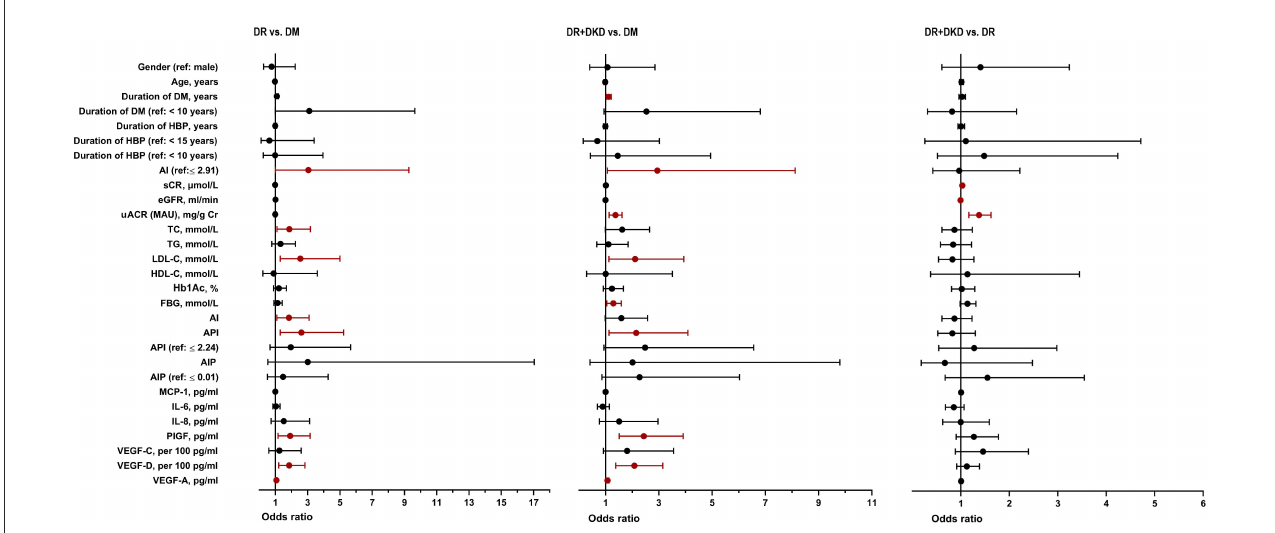
FIGURE1 Univariate logistic regression analysis between DM, DR, and DR+DKD groups. DM, diabetes mellitus; DR, diabetic retinopathy; DKD, diabetic kidney disease; HBP, high blood pressure; TC, total cholesterol; TG, triglycerides; HDL-C, high density lipoprotein cholesterol; LDL-C, low-density lipoprotein cholesterol; AI, atherosclerosis index [(TC-HDL-C)/HDL-C]; AIP, atherogenic index of plasma [log (TG/HDL-C)]; API, atherogenic plasma index (LDL-C/HDL-C); HbA1c, hemoglobin; FBG, fasting blood glucose; Scr, serum creatinine; eGFR, estimated glomerular filtration rate; uACR, urinary albumin/creatinine ratio; MCP-1, monocyte chemoattractant protein-1; IL-6, interleukin-6; IL-8, interleukin-8; PlGF, placental growth factor; VEGF, vascular endothelial